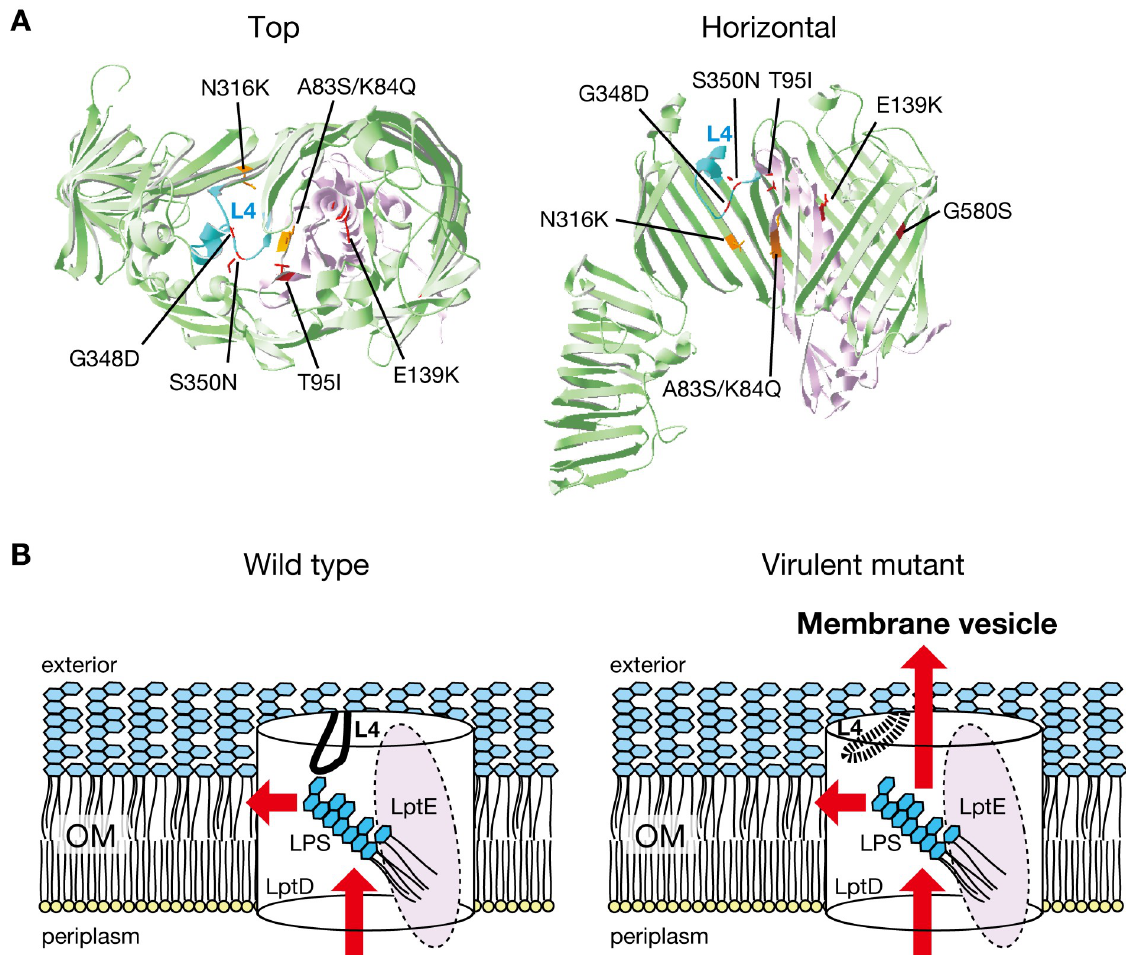
Fig 8. Location of the LptD and LptE mutations in the LptD-LptE complex structure. (A) The structural location of the LptD and LptE mutations that increase E . coli virulence is presented. The LptD-LptE complex structure is from S . flexneri (4rhb). The left image is from the exterior side, and the right image is from the horizontal side. In the right image, LptD 635–784 was removed for clarity. Loop 4 of LptD is shown in cyan, the other parts of LptD are shown in moss green, and LptE is shown in purple. The mutations obtained in the experimental evolution are in red, and the mutations present in clinical isolates are in orange. (B) Model for structural alteration and LPS translocation in the LptD and LptE mutants. In the wild-type strain, loop 4 plugs the LPS tunnel and assists in the translocation of LPS into the outer membrane (left). In the LptD and LptE mutants, the structure of loop 4 is changed, thereby attenuating its plug function and allowing LPS to be secreted into the extracellular milieu